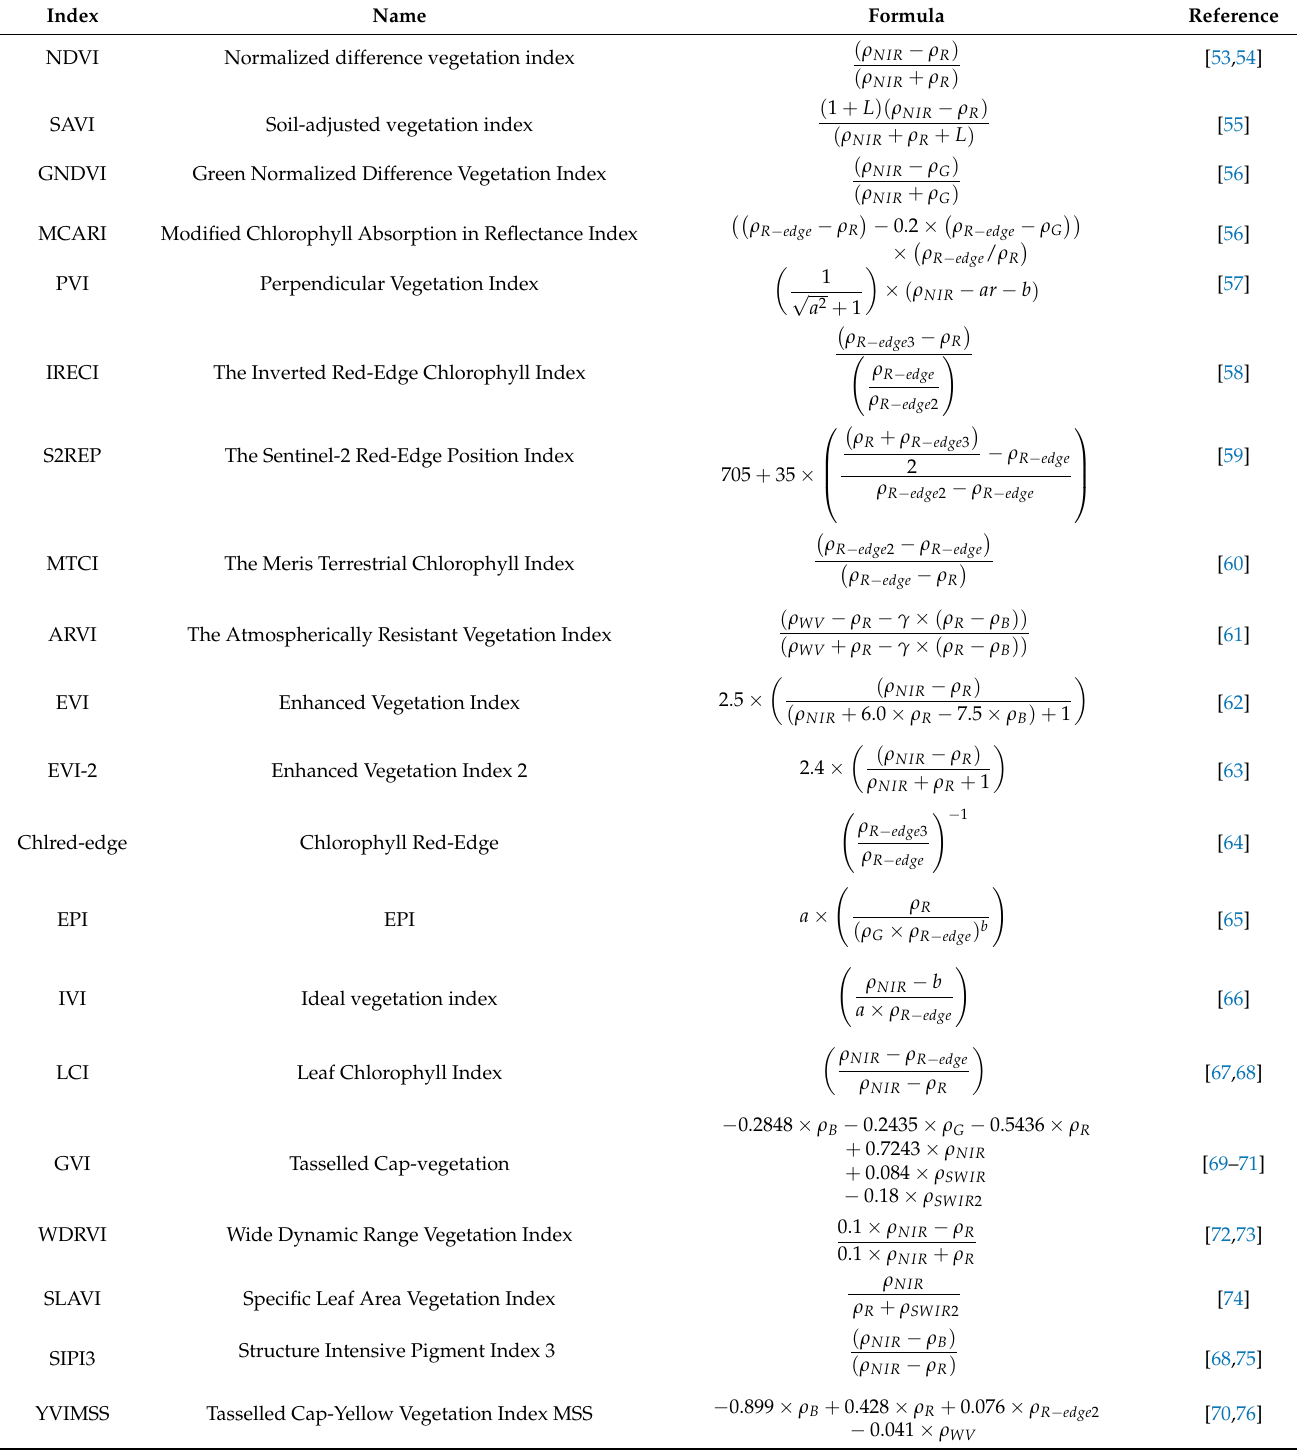
Table A1. Description to the 78 raster-based variables used in ML classification for this research, including 13 Sentinel-2 bands; and 22 Sentinel-2 band ratios ( Bn i ; Bn is the band number), B3DB8, B3DB2, B10DB3, B10DB2, B4DB10, B4DB2, B5DB4, Bn j B5DB2, B11DB5, B11DB2, B6DB11, B6DB2, B7DB6, B8ADB7, B8ADB2, B12DB8A, B12DB2, B1DB12, B1DB2, B9DB1, B9DB2; 6 Sentinel-1 variables as 2 bands (VV and VH), 2 ratios (VV/VH and VH/VV) and 2 indices (VH-VV and VV-VH); 4 DEM (cid:16) (cid:17) A variables (elevation, slope, Topographic Wetness Index (TWI) calculated as ln where A is the specific catchment area, tan ϕ and ϕ is the slope angle